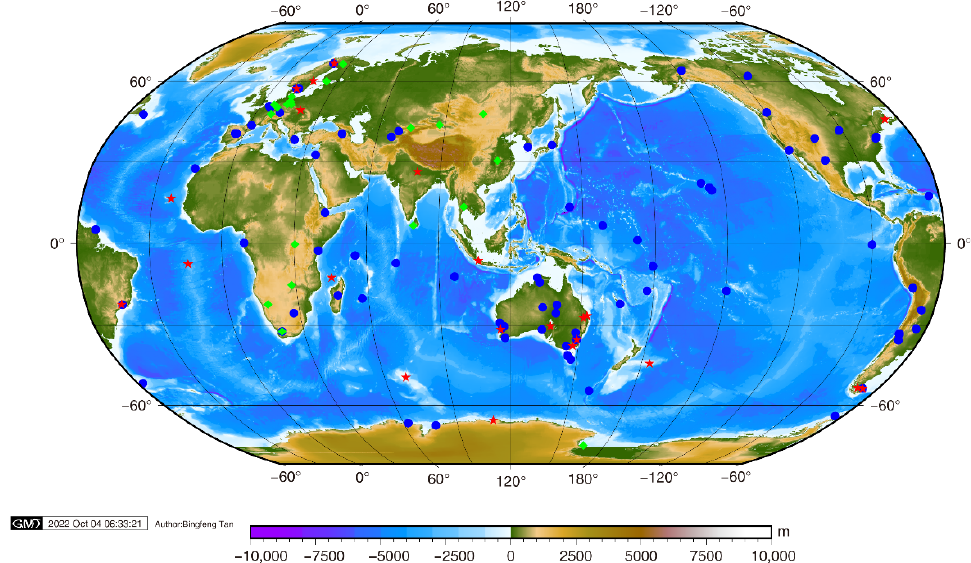
Figure 1. Tracking stations selected for BDS-3 POD. Sites are marked by green diamonds, blue circles and red five-pointed stars for Javad receivers, Septentrio receivers and Trimble receivers, respectively.